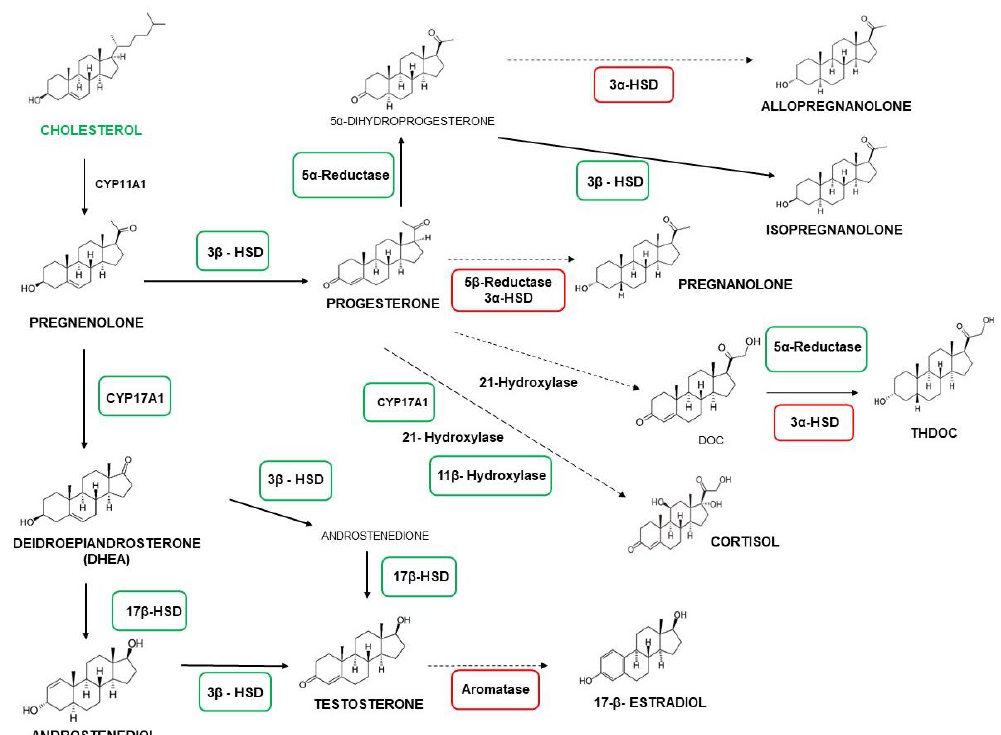
Figure 4. Neurosteroidogenesis pathway scheme. The biosynthetic pathway of neurosteroids is summarized. The enzymes that were transcriptionally expressed are in green boxes, except those at very low levels, which are in red boxes. A full arrow represents an enzymatic conversion that most probably occurred in the investigated microglial cells, whereas the dotted rows show a poorly represented one.